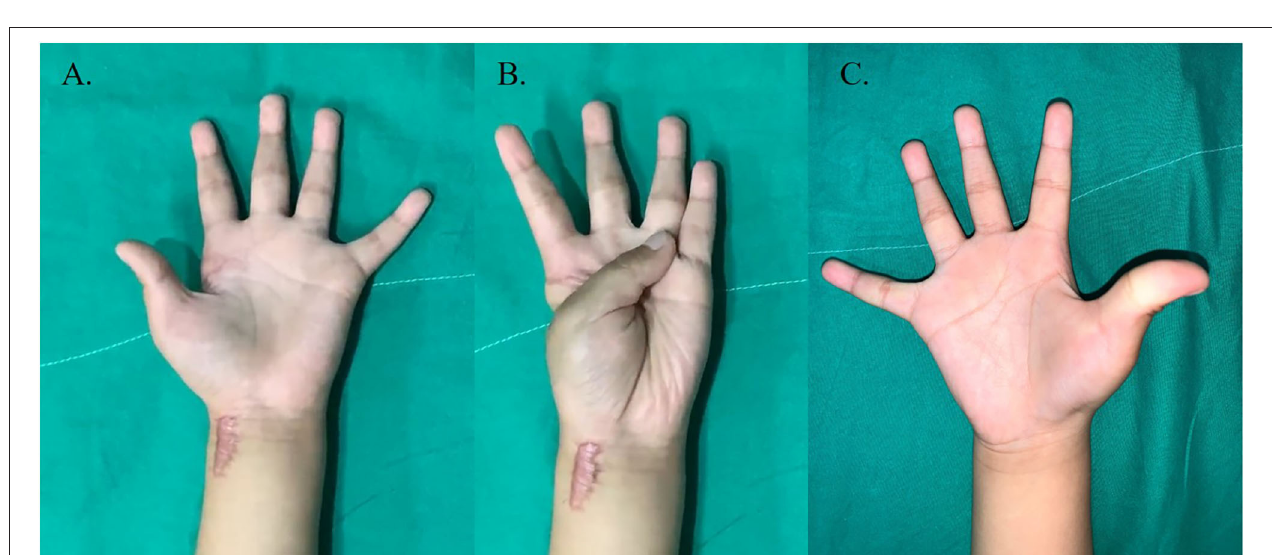
FIGURE 4 | Clinical photographs of both thumb at 2 years post-treatment. (A,B) Left thumb showing opposition with ring finger. (C) Right thumb showing widened narrow web